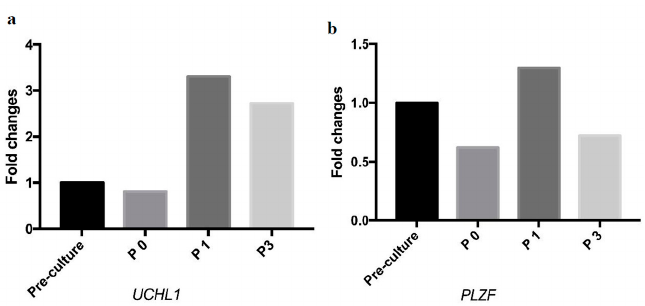
Figure 5. SSC-like cell clusters transcribe the message RNA of SSC markers during passaging. ( a ) Real-time quantification of the expression level of the SSC markers, ubiquitin carboxyl-terminal hydrolase isozyme L1 (UCHL1) and ( b ) promyelocytic leukaemia zinc finger protein (PLZF) during passaging. Pre-culture: the digested testicular cells. P0: Primary passage. P1: First passage. P3: Third passage.